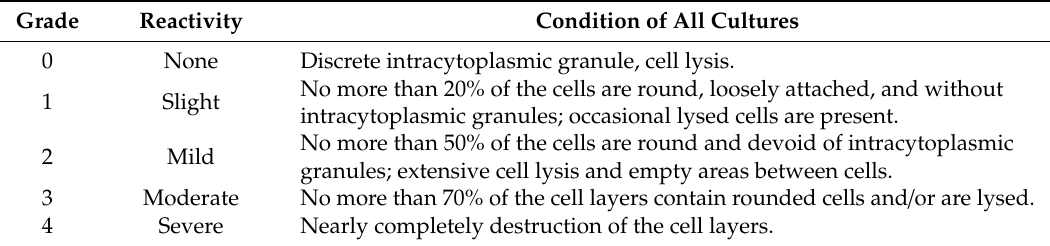
Table 1. Reactivity grades for elution